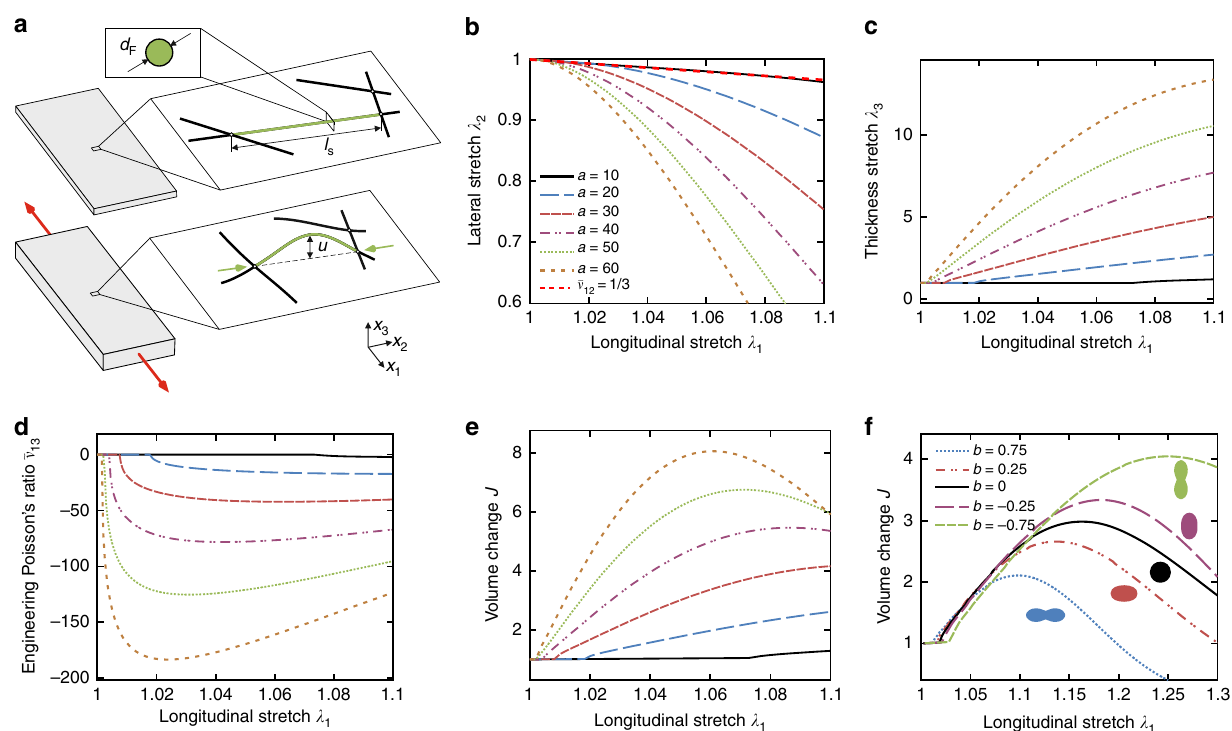
Fig. 1 Theoretical model of the auxetic mechanism. a With network extension, longitudinally oriented segments reorient and subject transversal ones (green) to compressive loads, so that they buckle and de fl ect out of plane ( x 3 ) with a maximum de fl ection u . b , c Lateral in-plane ( λ 2 ) and thickness, i.e., out-of-plane = d ( λ 3 ) stretches vs. longitudinal stretch λ 1 for different segment aspect ratios a ¼ l . d Engineering Poisson ’ s ratio ~ ν 13 computed from ( c ). e Volume s F changes J computed from (b, c). f Effect of initial segment orientation of segments with aspect ratio a ¼ 20, speci fi ed by the concentration parameter b of the von-Mises distribution. Increasing values of b indicate alignment with the longitudinal axis, pictograms show polar plots of the